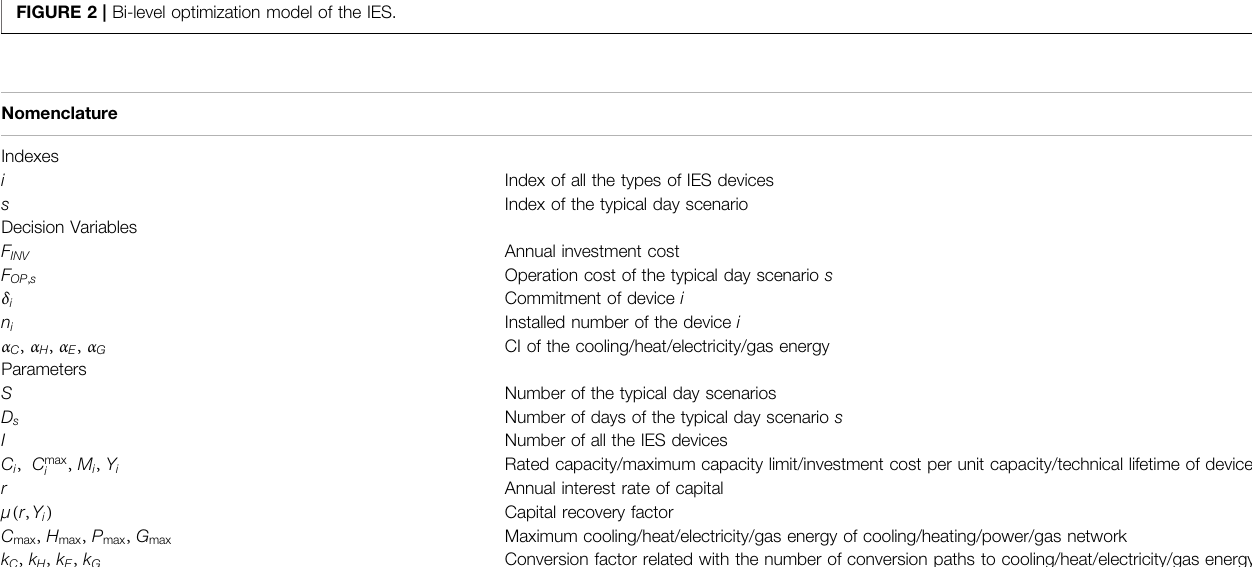
FIGURE 2 | Bi-level optimization model of the